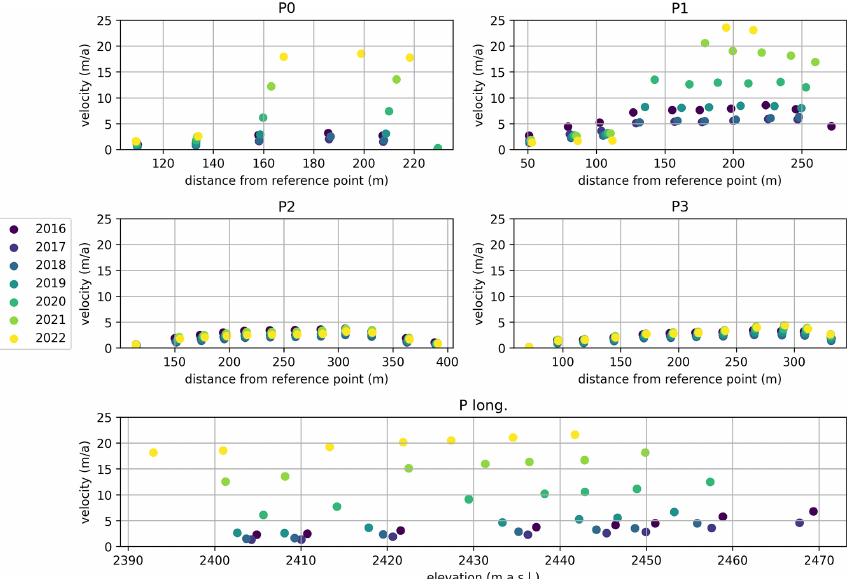
Figure 11. Block velocities for the four cross profiles (P0–P3) and for the longitudinal profile (P long.) (in ma − 1 ) for 2015–2016 to 2021– 2022. The x axis shows the distance from the orographic left reference point for P0, P1, P2, and P3, respectively. For P long., the x axis shows the elevation of the blocks in each year. In P0, the third block from the right could not be located in 2018–2021, presumably because it rotated so that the marking was obscured. In P1, a block was similarly lost in 2021, and three more were lost in 2022. For P. long., only blocks that were found every year since 2016 are